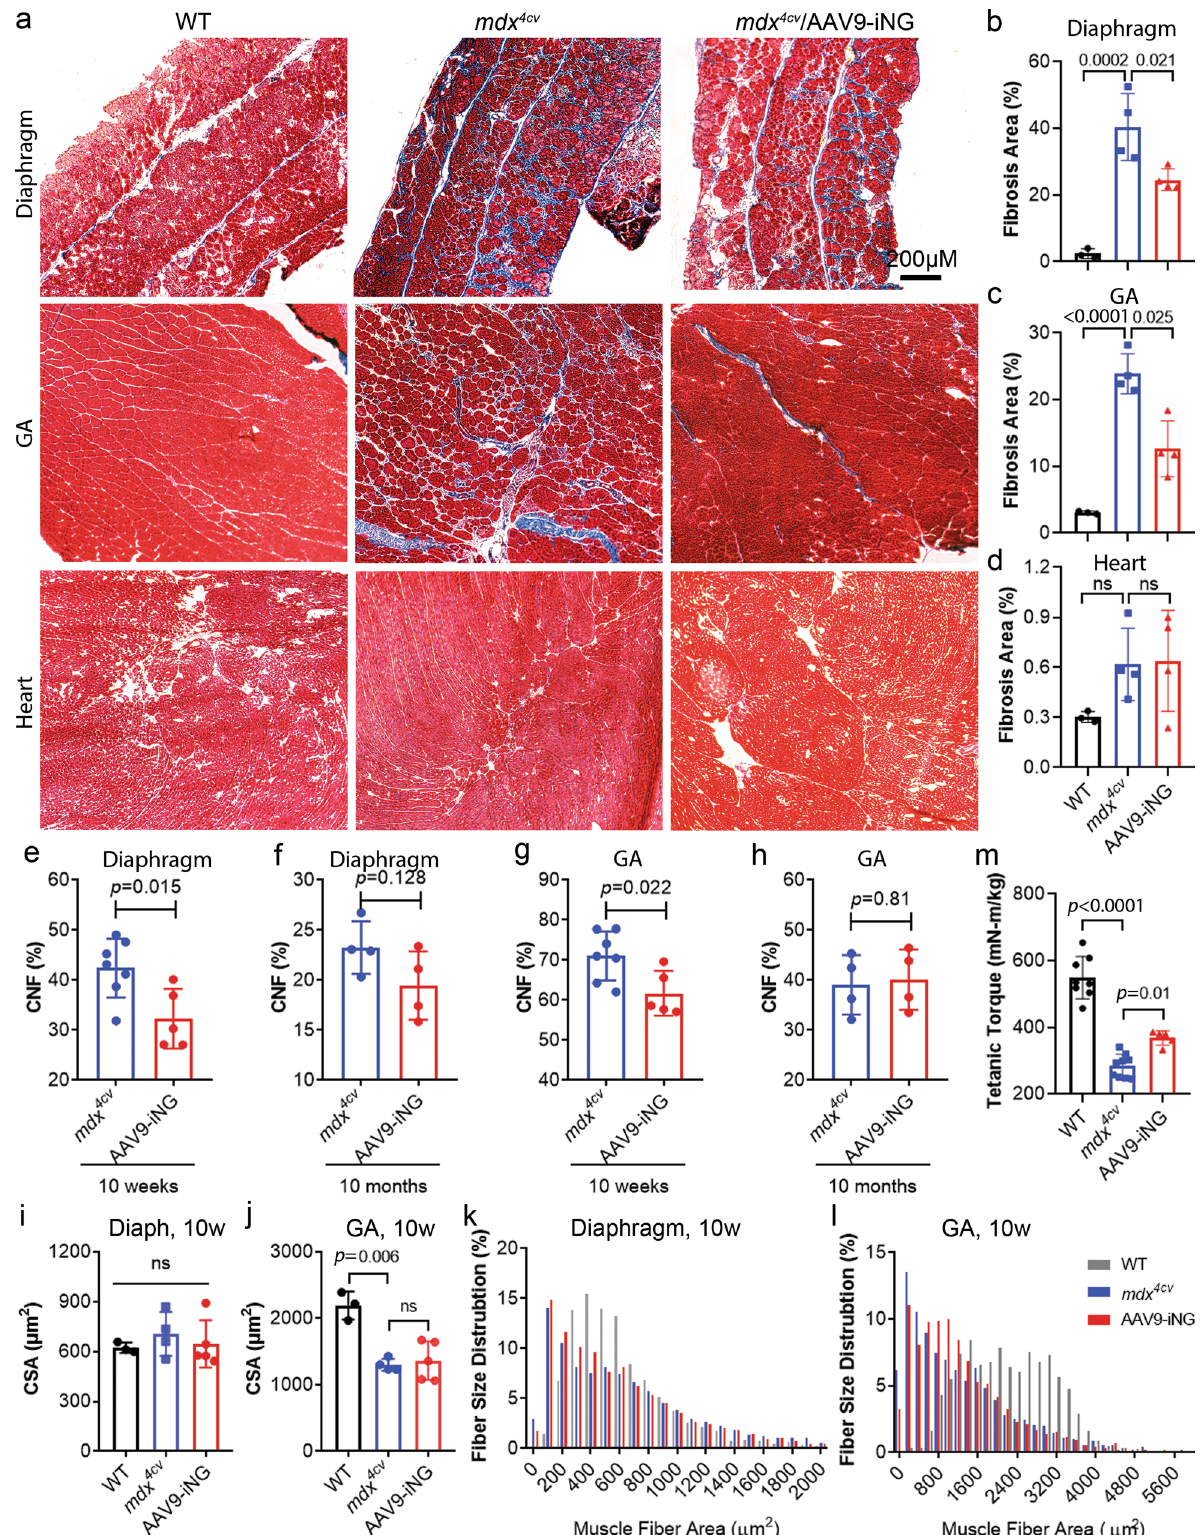
Discussion Collectively, we have improved the split ABE-NG for AAV- mediated in vivo delivery by engineering a new NG PAM- interacting domain variant, a new adenine deaminase domain with higher on-target DNA editing ef fi ciency without compro- mising the high fi delity of ABE-V82G, and a Gp41-1 intein